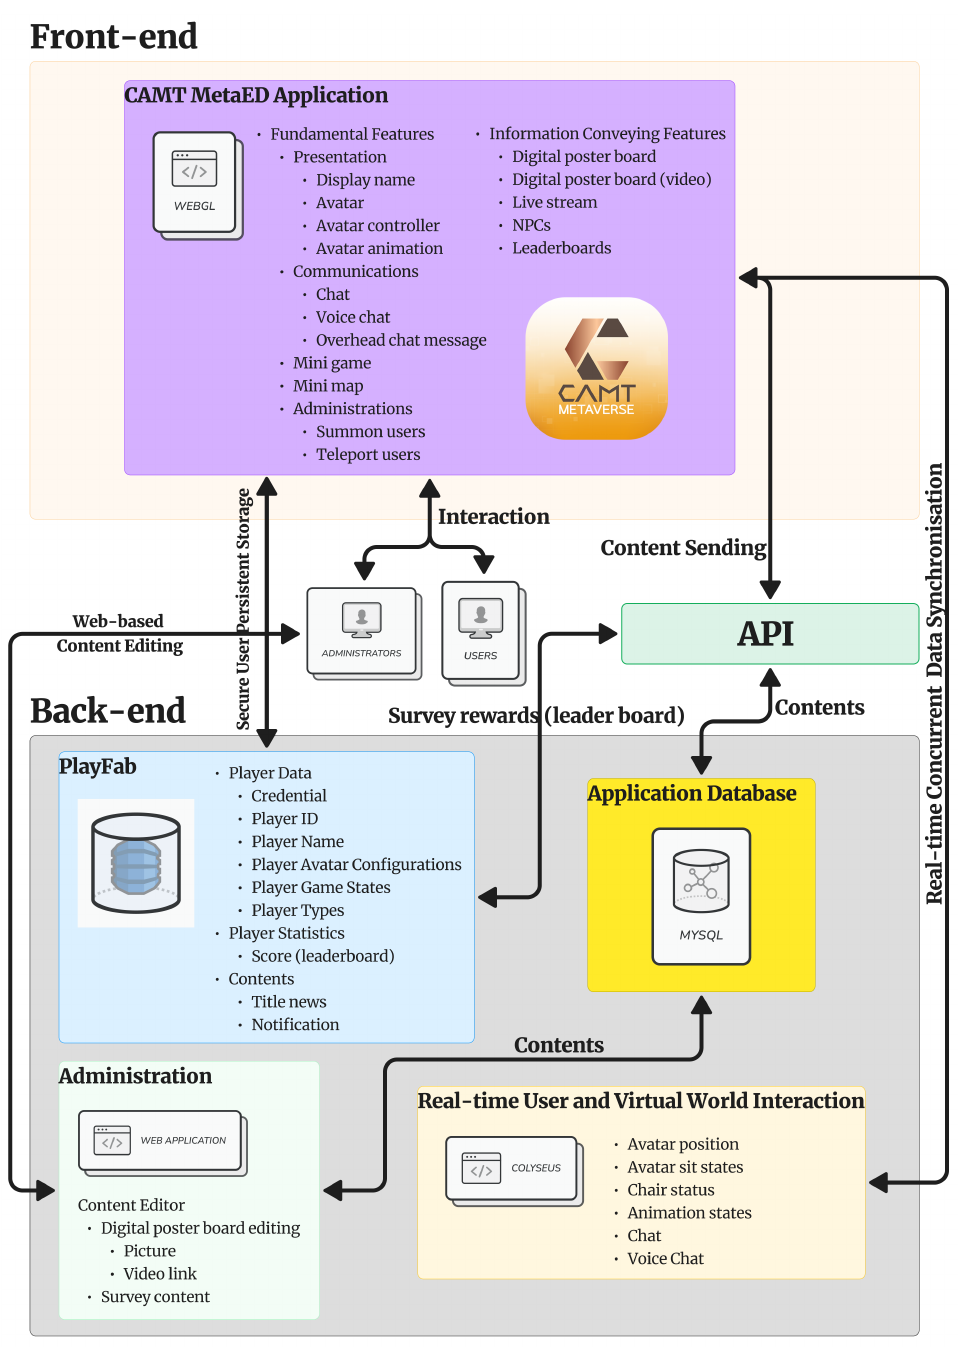
Figure 1. The architecture of the proposed metaverse. The front-end is a Unity WebGL application connected to the back-end